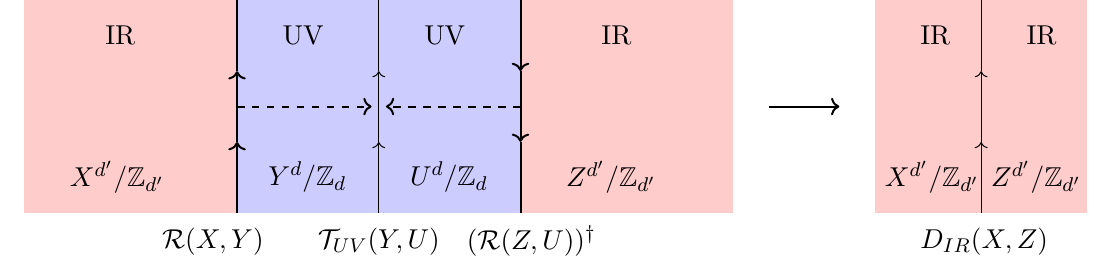
Figure 3 . Setup for the RG flow of topological